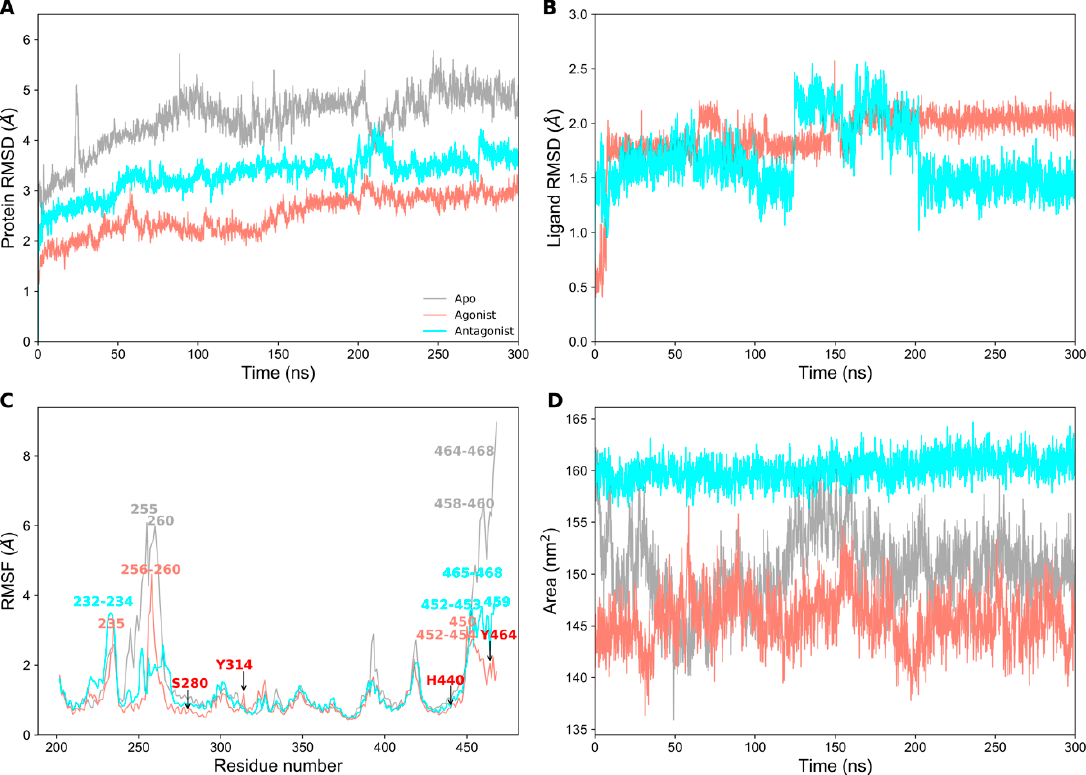
Figure 1. Analysis of the 300 ns molecular dynamics (MD) simulation productive phases of apo, agonist-, and antagonist-bound forms of PPAR- α . ( A ) Root mean square deviation (RMSD) of the protein backbone atoms with respect to the equilibrated structure; ( B ) RMSD of the agonist (13M) and antagonist (471) molecules with respect to the minimized structures; ( C ) Root mean square fluctuations (RMSF) of apo, agonist-, and antagonist-bound forms of PPAR- α and the residues with high fluctuations are shown. The residues important for ligand binding are labeled in red. ( D ) Solvent accessible surface area of apo, agonist-, and antagonist-bound forms of PPAR- α . The data for apo, agonist-, and antagonist-bound forms of PPAR- α are shown in gray, salmon, and cyan, respectively.